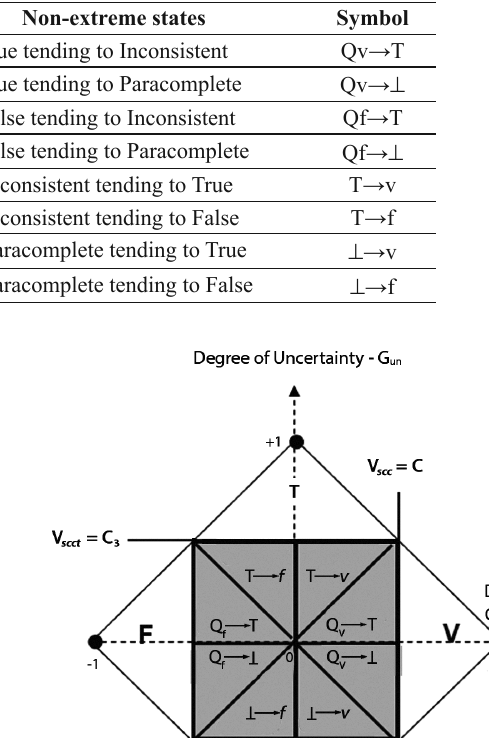
Extreme and Non-extreme states.